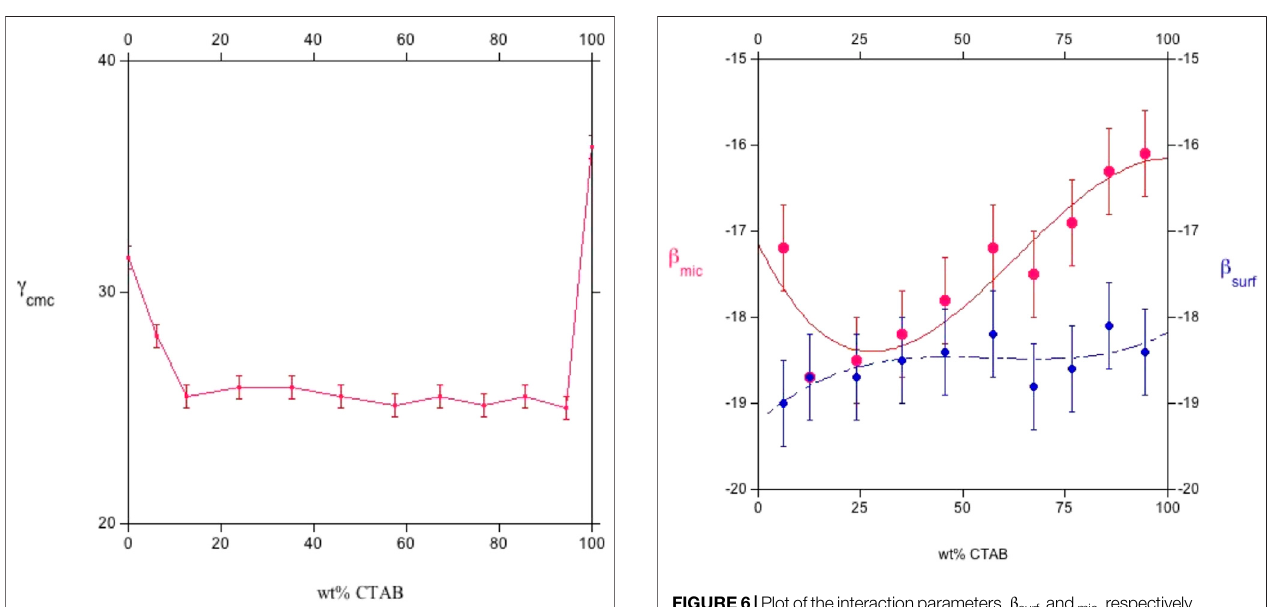
FIGURE 5 | The surface tension at the cmc , γ cmc (in mN m − 1 ), vs. CTAB wt% for sodium octylsulfate/cetyltrimethylammonium bromide mixtures, at 25.0 ° C. The central part ofthe plot ischaracterized by nearly constant surface tension, oscillating around 25 mN m − 1 . The plot was redrawn by data in Ref. (Comelles et al., 2015).